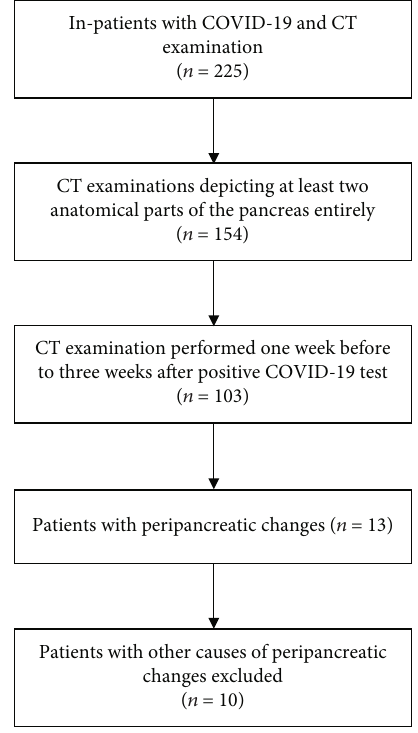
Figure 1: Study fl ow